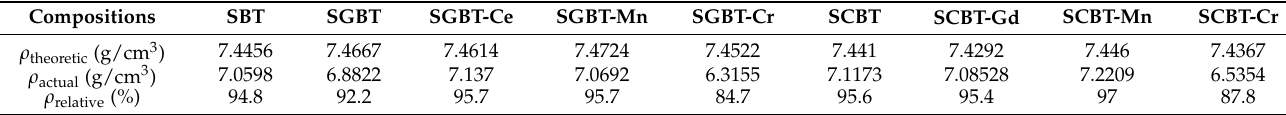
Table 2. Density data of the oxide-modified SBT